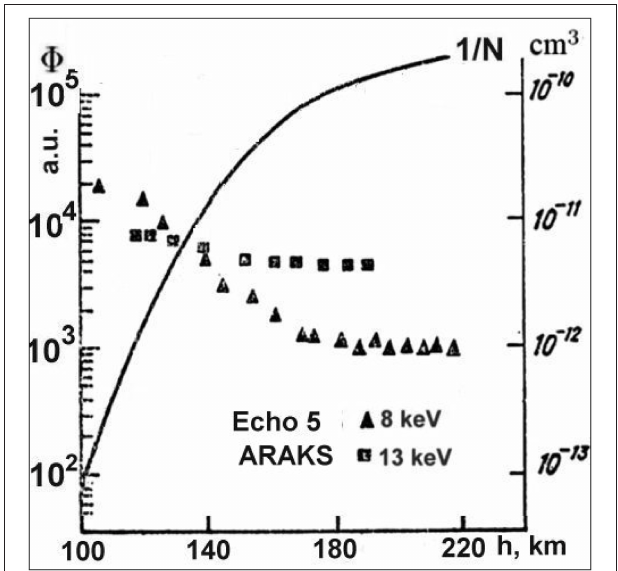
FIGURE 8 | Variation of the scattered beam electrons in the ARAKS (squares) and Echo 5 (triangles) experiments. The solid line shows the model value of N − 1 in cm 3 . After Grandal (1982a) and Arnoldy et al. (1985). Reprinted by permission from COSPAR and American Geophysical